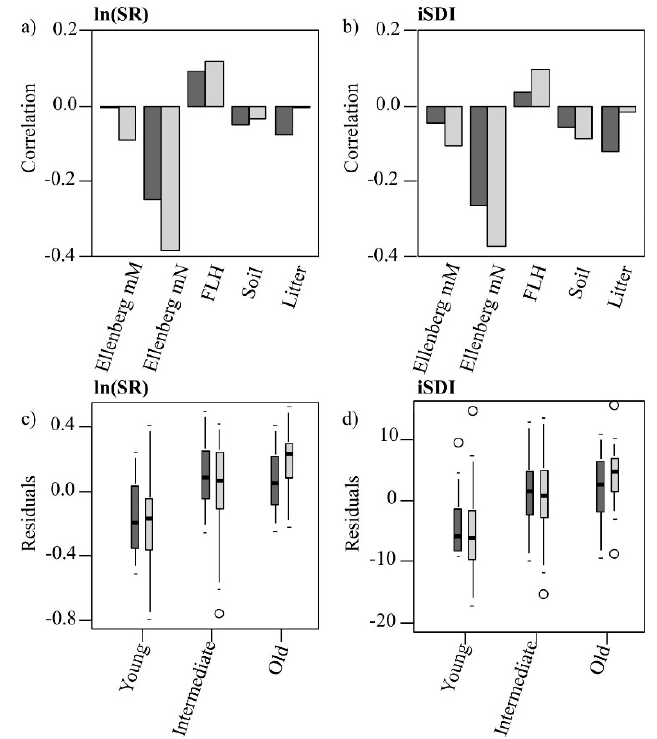
Figure 6. ( a , b ) Pearson’s correlation coefficients of the residuals of the PLSR models’ (Model 1 = dark; Model 2 = light) predictions of ( a ) the species richness (ln(SR)) and ( b ) the inverse Simpson’s diversity index (iSDI) with different environmental variables (moisture availability, Ellenberg mM; nutrient availability, Ellenberg mN; field-layer height, FLH; cover of bare ground, Bare ground; and cover of litter, Litter); ( c , d ) Distribution of the residuals of ( c ) the species richness (ln(SR)) and ( d ) the inverse Simpson’s diversity index (iSDI), within the three grassland age-classes, predicted by Model 1 (dark) and Model 2 (light).